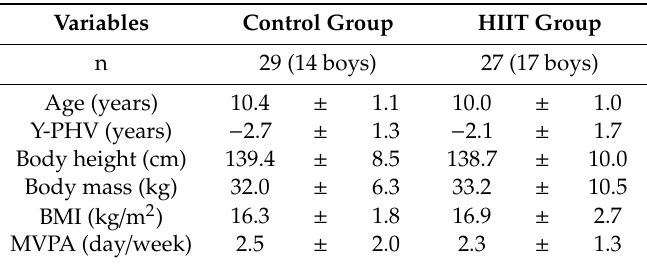
Table 1. Participant’s baseline demographics.